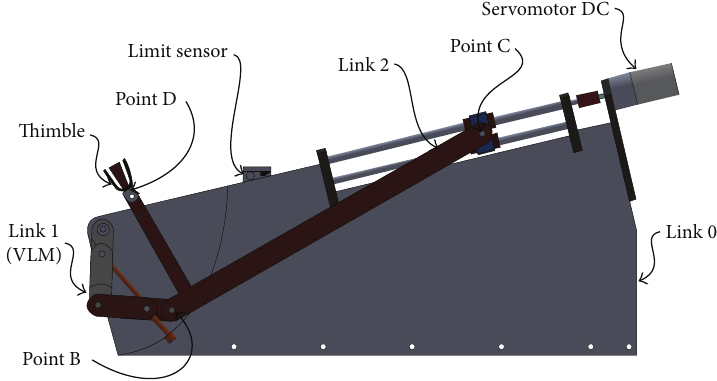
Figure 3: R-RRT mechanism of the middle